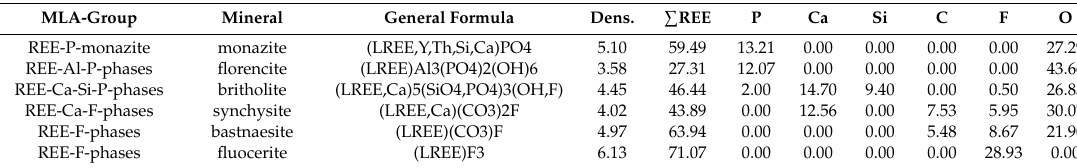
Table 1. List of REE-bearing minerals and their assignment to mineral groups as applied in the presented MLA studies of REE ores. The given mineral compositions (in wt %; density Dens.) are not representative and refer to the analysed REE ores and / or are partly taken from databases (e.g.,